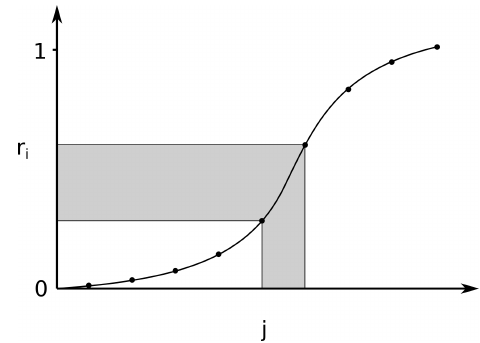
Figure 2. Resampling principle. After drawing a random number r i from a uniform distribution on [ 0 , 1 ] , the i th particle is resampled to the model state of the j th particle if r i falls in the corresponding bin in the cumulative distribution of the normalised